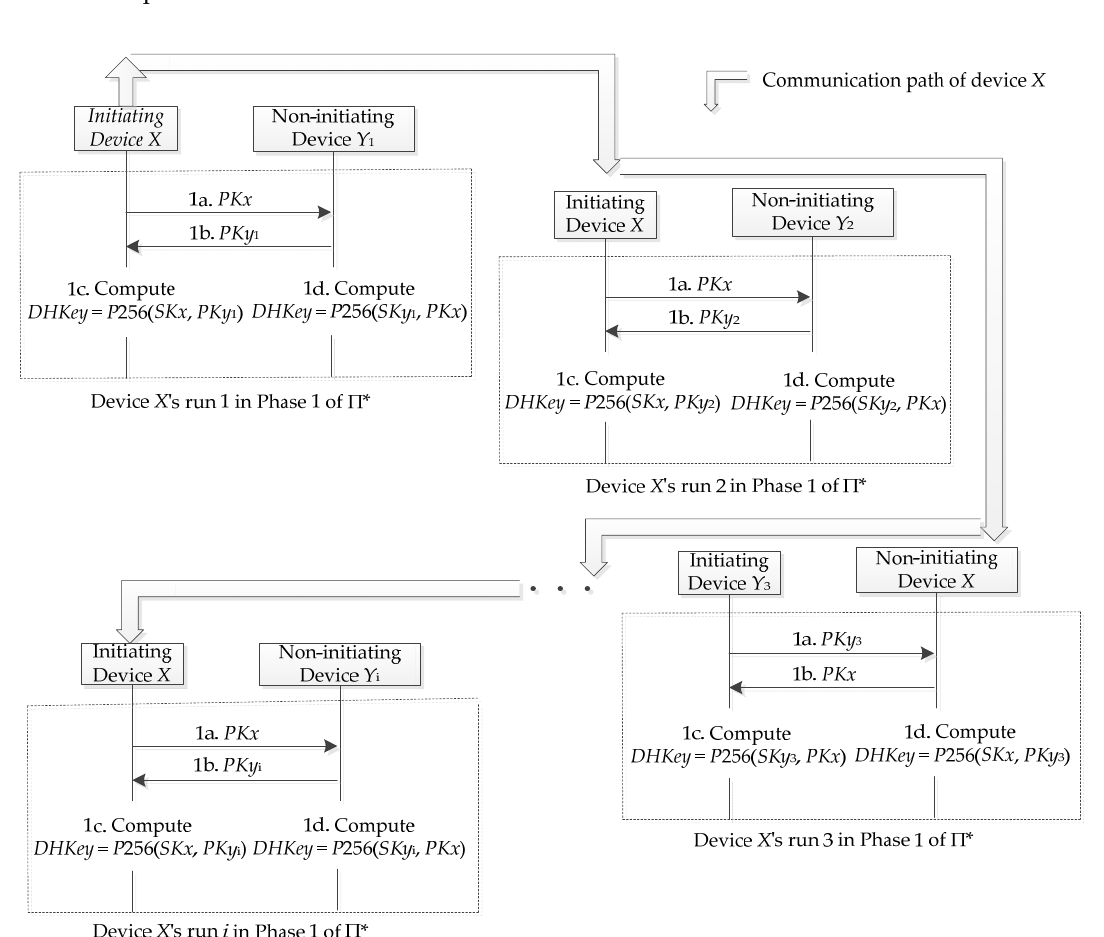
Figure 4. An example of the tracked device X ’s communication profile.